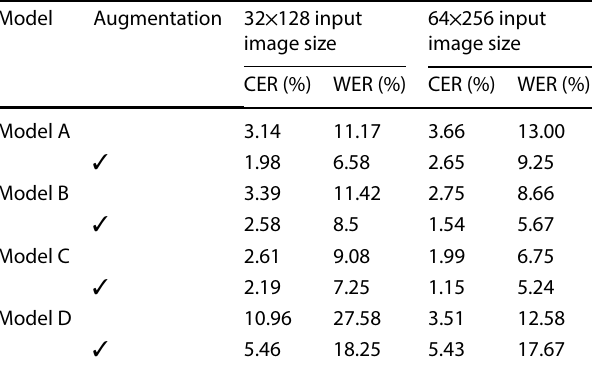
Table 4 Recognition performance comparison of AHWR models on our test dataset, with and without augmentation using two differ- ent input word image sizes.